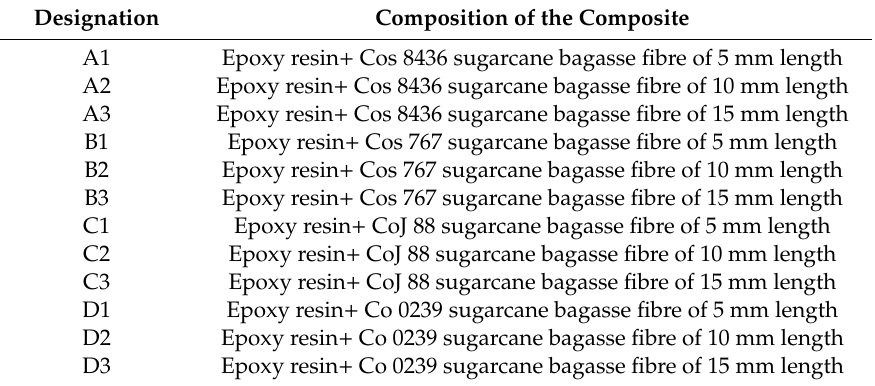
Table 2. Designation of